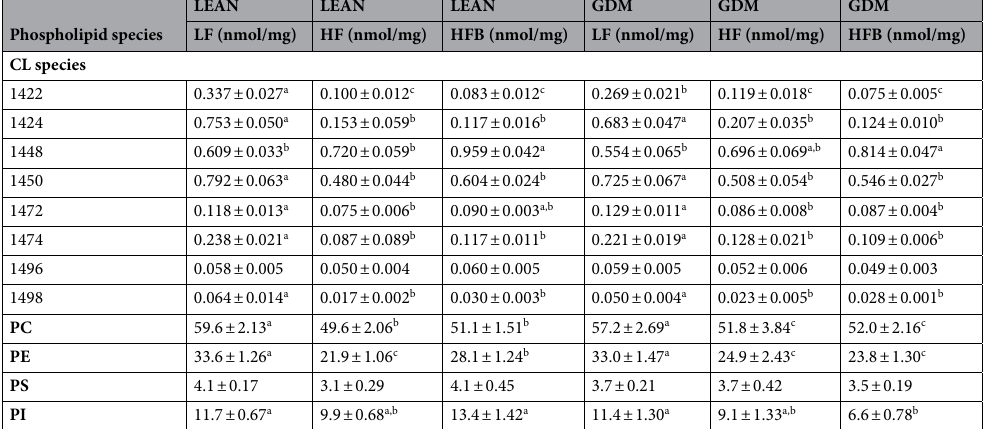
Table 4. Quantitation of phospholipids and CL molecular species in the liver. Quantitation of phospholipids and molecular species of CL from the liver of offspring following 12-weeks of the indicated diet (LF, HF, HFB). Values are means ± SEMs (n = 7–10), means without a common letter differ, p < 0.05.